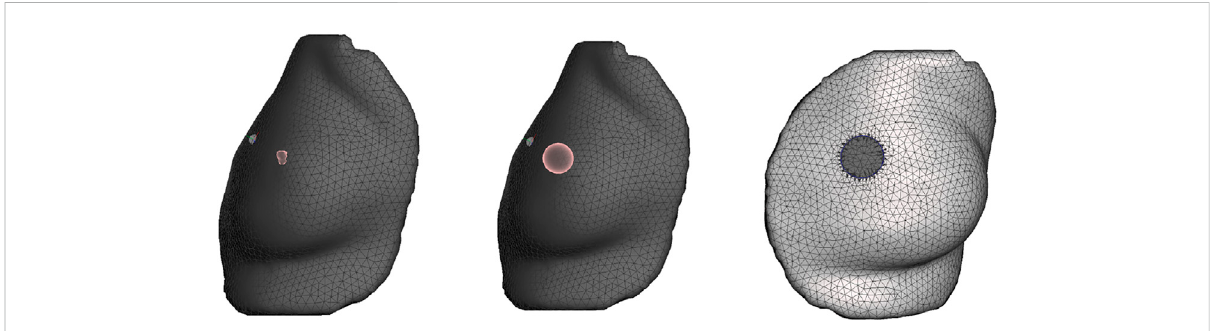
FIGURE 5 Fromlefttoright:(i)Locationoftumorhighlightedontopofthechestwall;(ii)2-cm-radiusspherecenteredonthetumor;(iii)regionofinterest on the skin surface produced by intersecting the sphere.